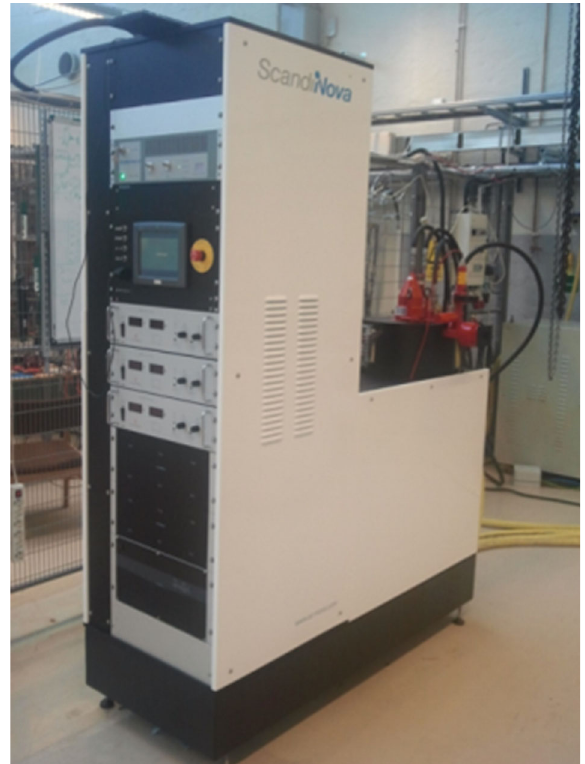
FIG. 24. Photograph of the compact rf transmitter that provides all power to photoinjector and linac.